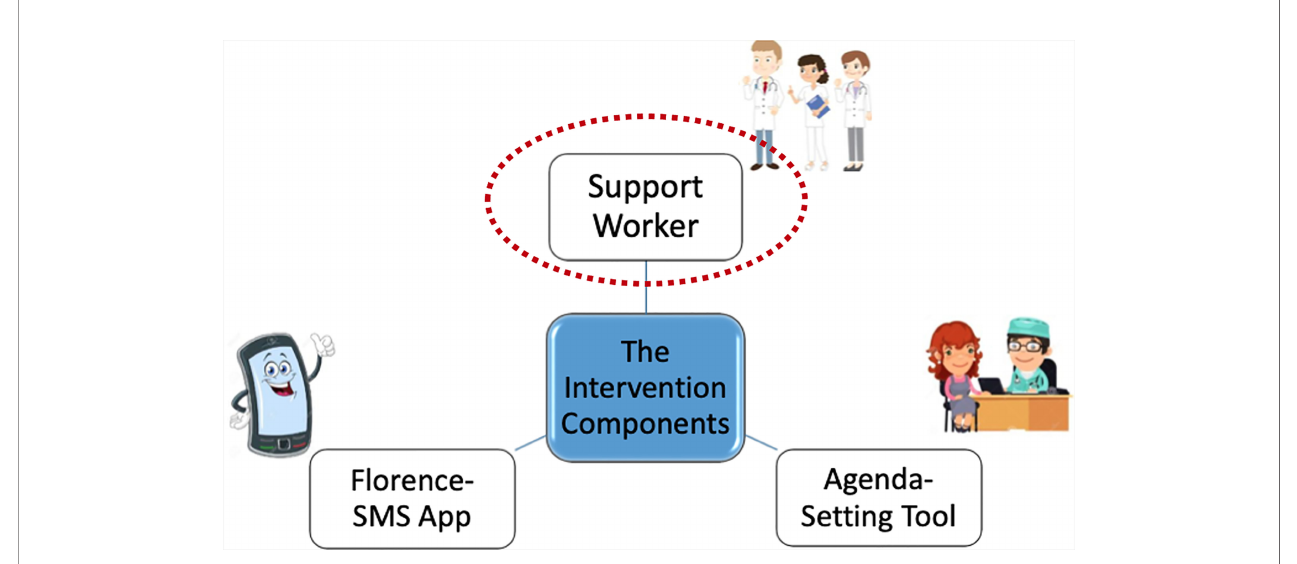
FIGURE 1 | D1 Now intervention